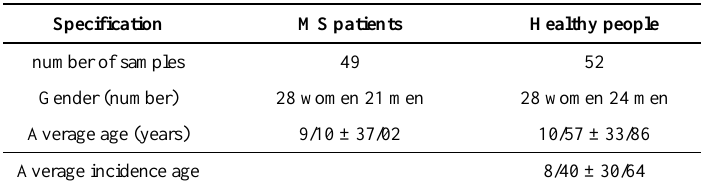
Table 2. Clinical information of patients and healthy